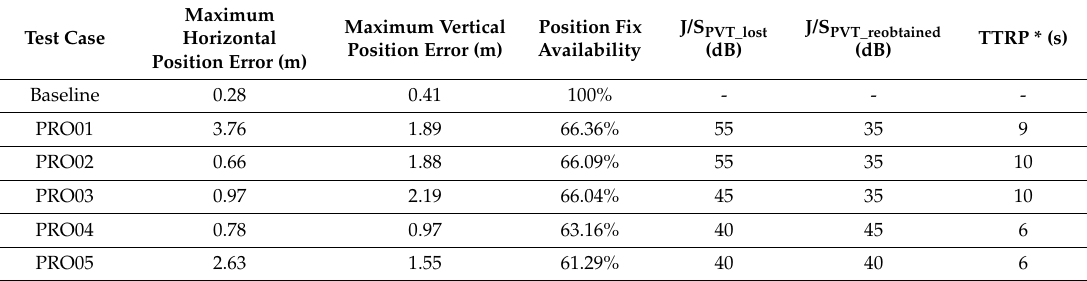
Table 5. Test results for PRO